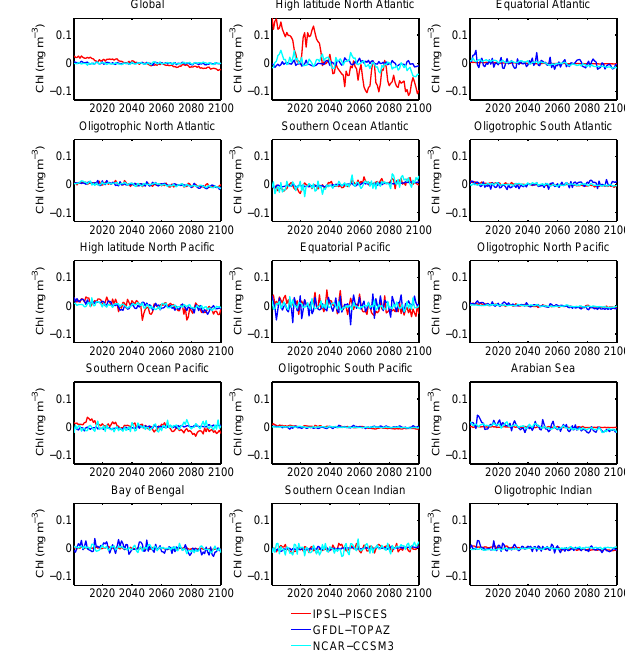
Fig. A3. Ocean chlorophyll concentrations anomalies projected for 2001–2100 averaged globally and in 14 biomes from three-ocean biogeochemical models forced with the A2 scenario from the Spe- cial Report on Emission Scenarios (Nakicenovic et al., 2000). The trends magnitudes and significance are presented in Table 2.